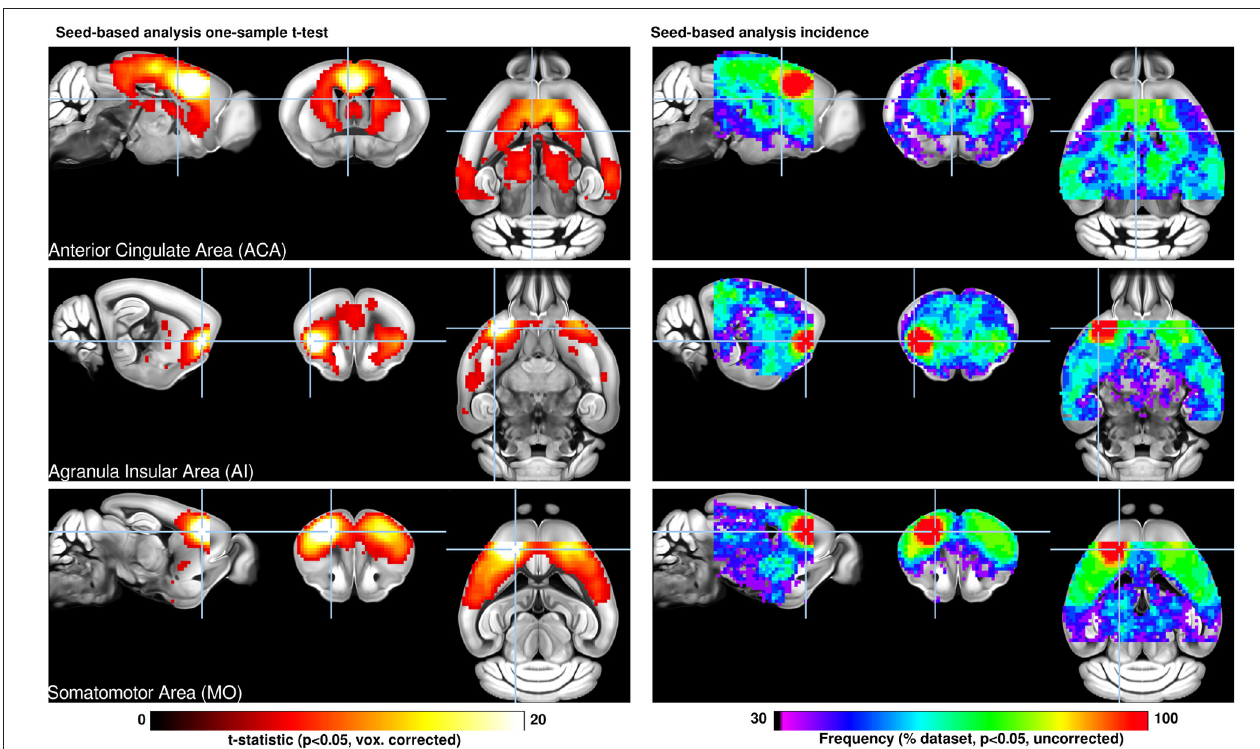
FIGURE 1 | Seed-based analysis (SBA) for three selected seeds positioned in the left hemisphere. One-sample t -test maps of individual functional connectivity maps reveal the full extent of SBA-derived resting-state networks in the mouse brain across 98 independent scans. Functional connectivity (FC) related to a seed located in the anterior cingulate area reveals the extent of the mouse default mode network including dorsal caudate-putamen, dorsal thalamus, and peri-hippocampal areas. The seed in the insular area reveals significant FC in dorsal cingulate and amygdalar areas, corresponding to areas associated with the human salience network. Interhemispheric homotopic FC is found relative to the somatomotor seed, together with lateral striatal FC. Overlap maps indicate the percentage of data sets presenting significant FC which recapitulate the features above. Reproduced with permission from Grandjean et al.